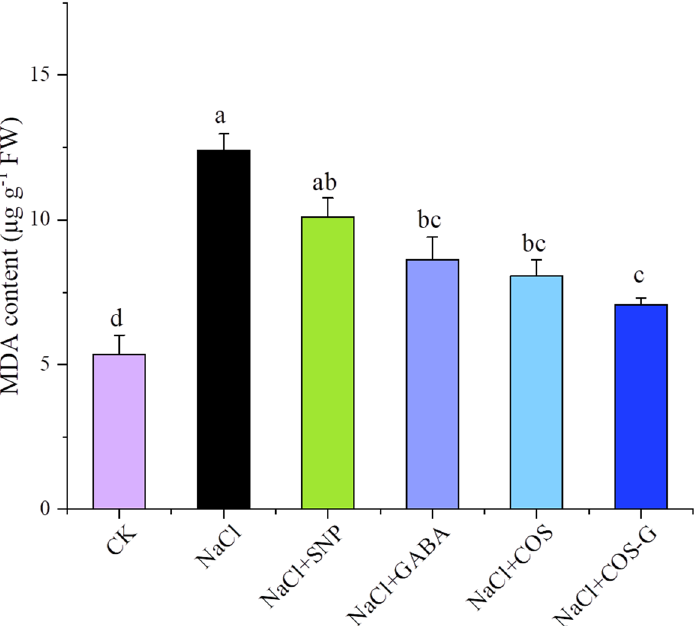
Figure 5. Effect of different treatment groups on malondialdehyde (MDA) content of wheat seedling leaves under salt stress. Values are the mean ± SD of three replicates in independent experiments. Different letters ( a,b,c,d ) indicate significant differences at p < 0.05 on the same